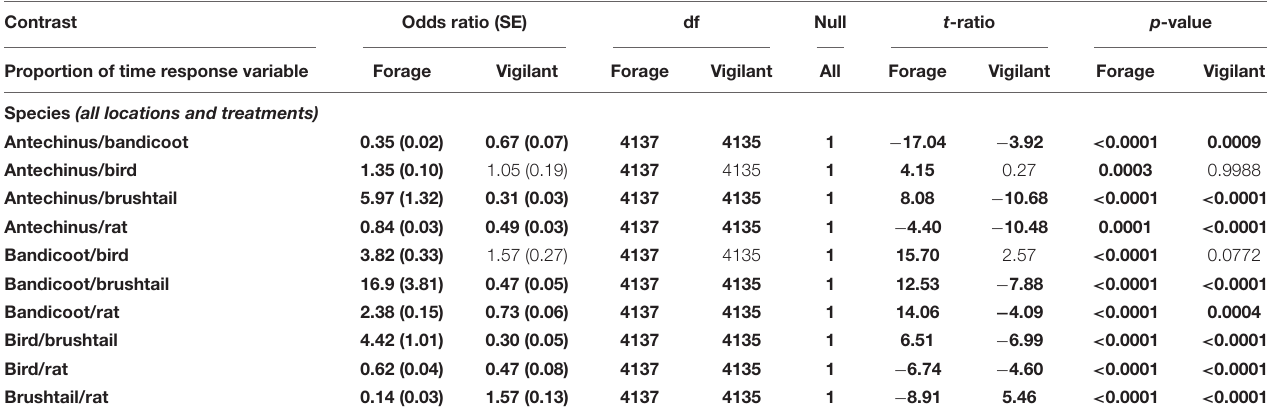
TABLE 8 | Between species pairwise contrast ratios for estimated marginal means from generalized linear mixed models with zero inflation and dispersion parameters for each response of time spent foraging and time spent vigilant, under the explanatory variables of treatment and environment. Contrast Odds ratio (SE) df Null t -ratio p